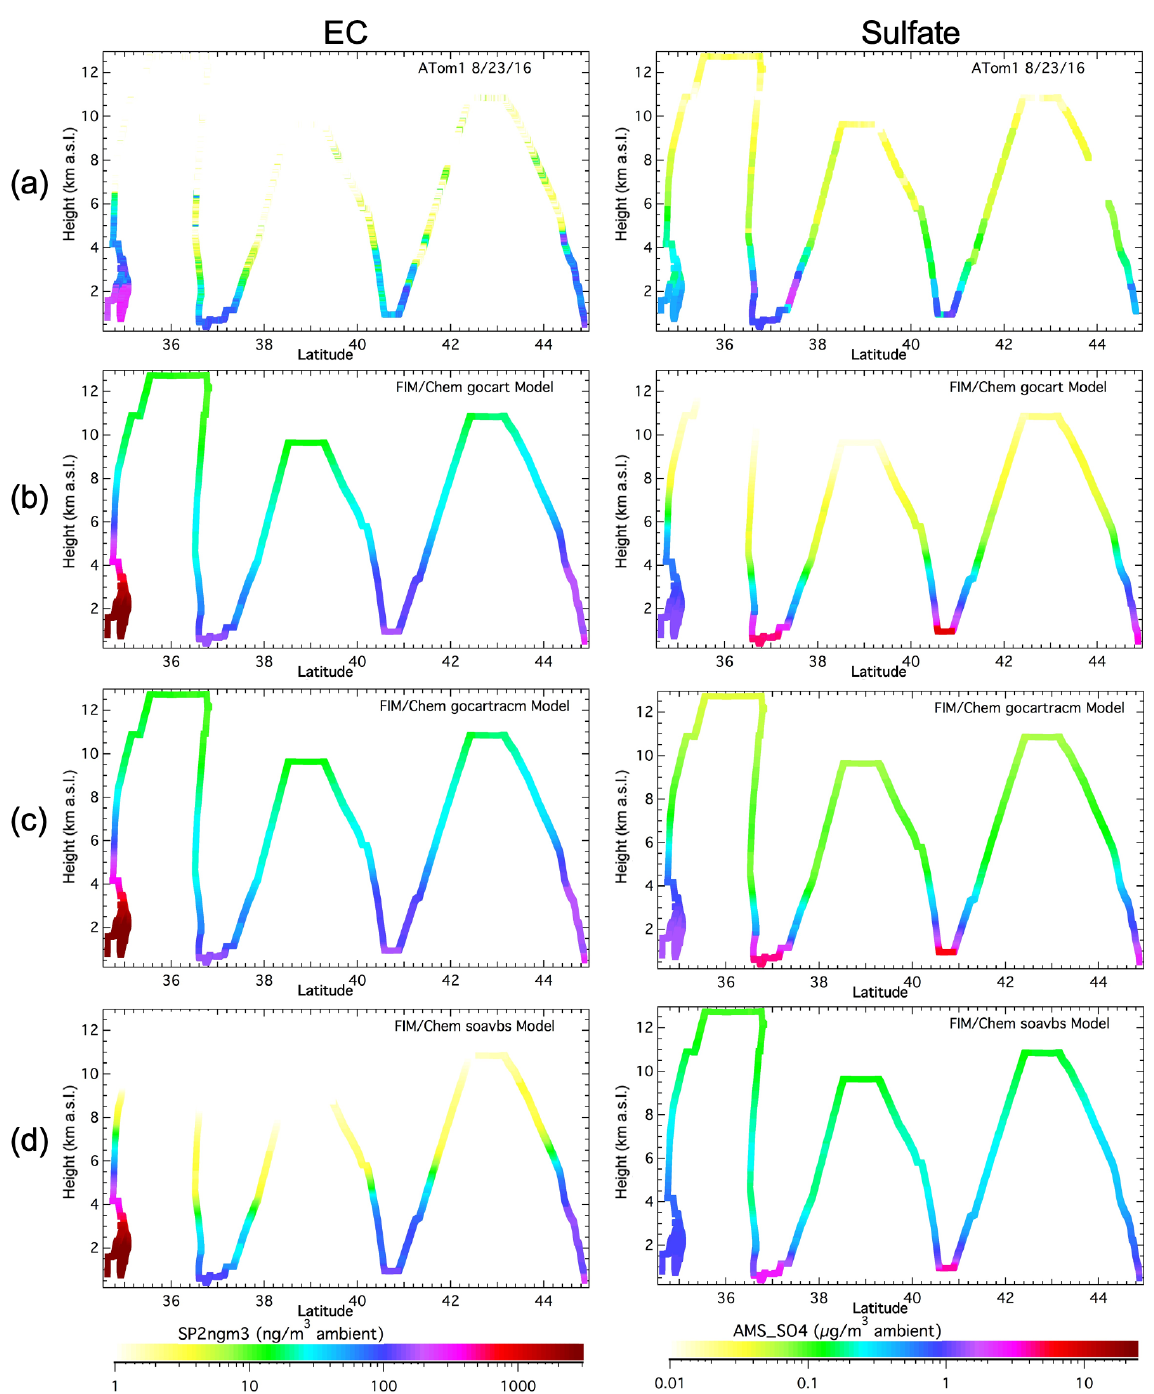
Figure 10. Height–latitude profiles of EC and sulfate over the United States on 23 August 2016 for (a) ATom-1; (b) GOCART; (c) RACM_GOCART; and (d)